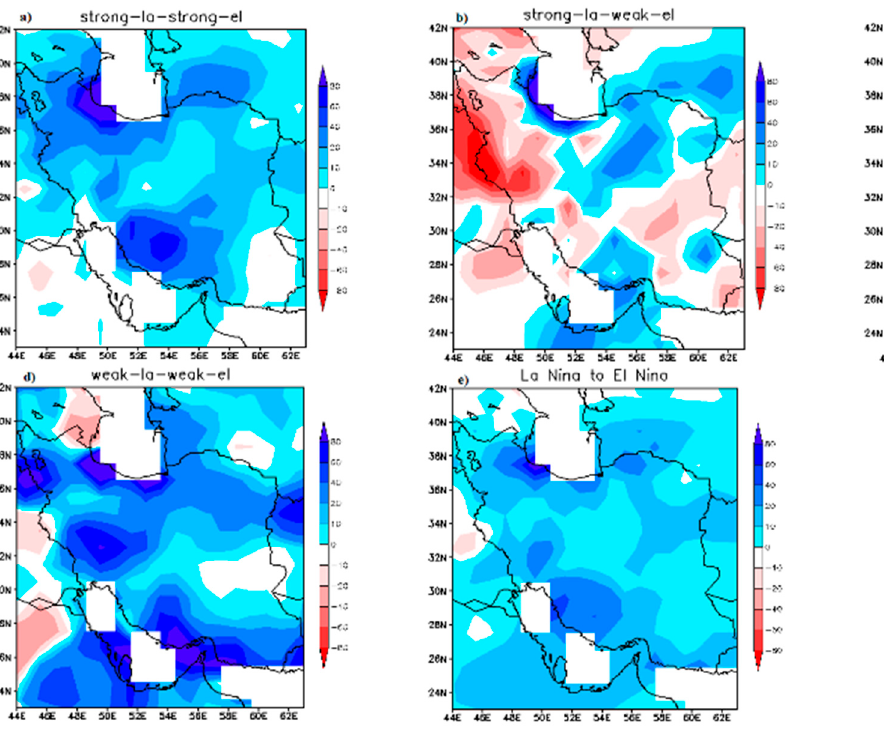
Figure 8. Same as Figure 7, but for type 2 transitions.